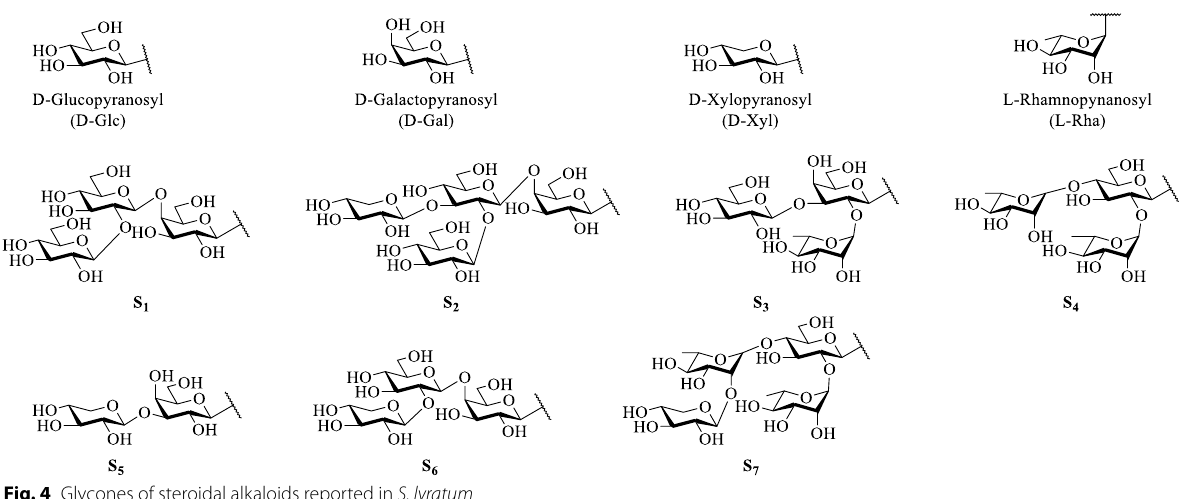
Fig. 4 Glycones of steroidal alkaloids reported in S.